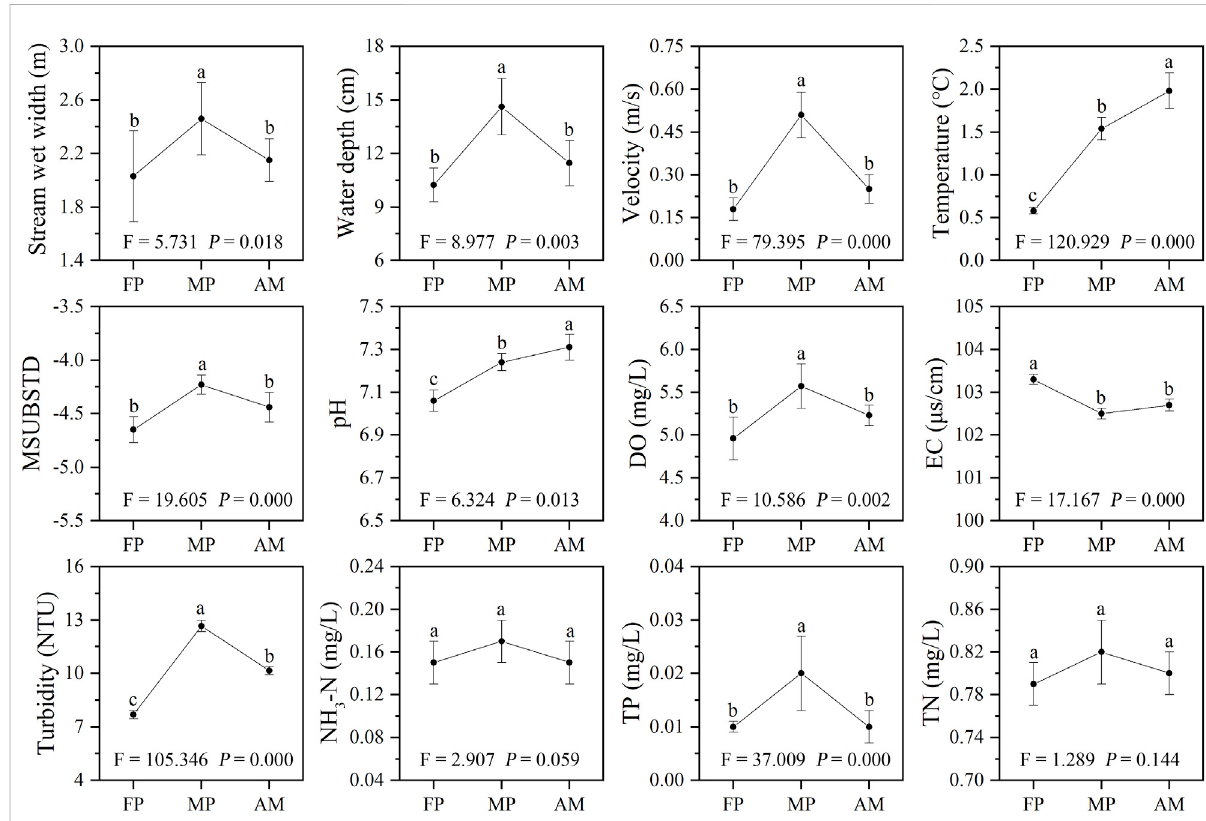
FIGURE 2 Temporalchanges (FP,freezing period; MP, melting period; AM, after the melting period) of stream physicochemical characteristics. Data were shown as mean ± SE. Lowercase letters above each data point denote signi fi cant differences after one-way ANOVA followed by post hoc Tukey (parameters with the same letter are not signi fi cantly different between studies). Different lowercase letters indicate signi fi cant differences in invertebrate community structure caused by different